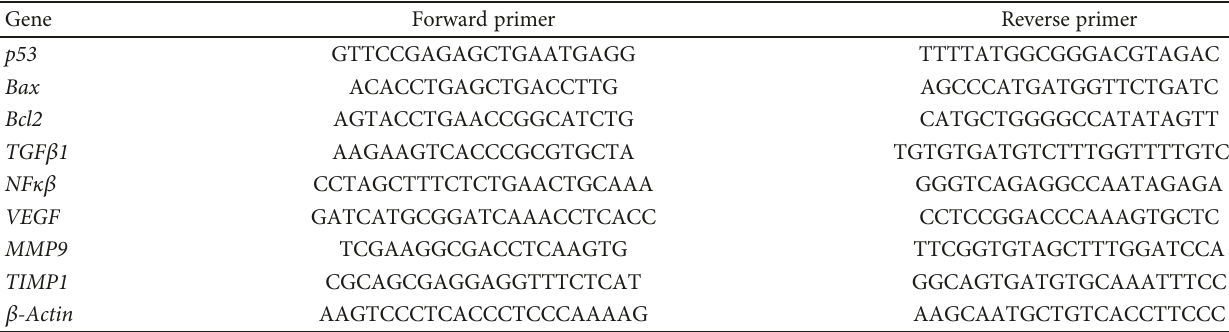
Table 1: Primers used for real-time